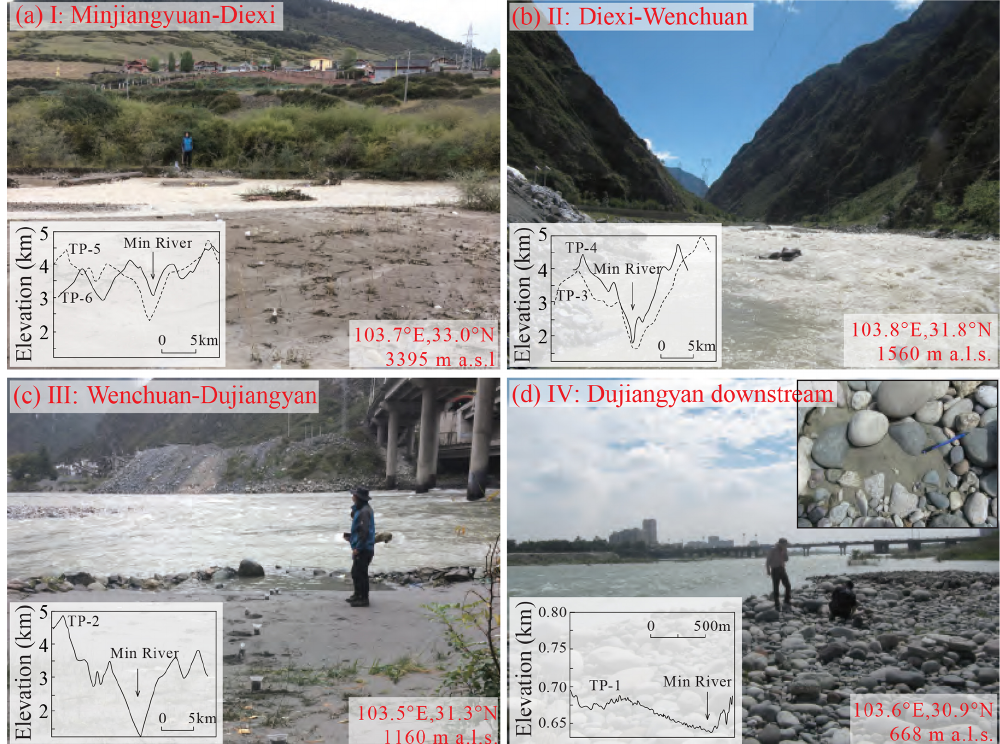
Figure 2. Photographs of field sampling sites in the upper Min River. The locations of cross-sections through the Min River valleys (Zhang et al., 2005) are shown in Fig.